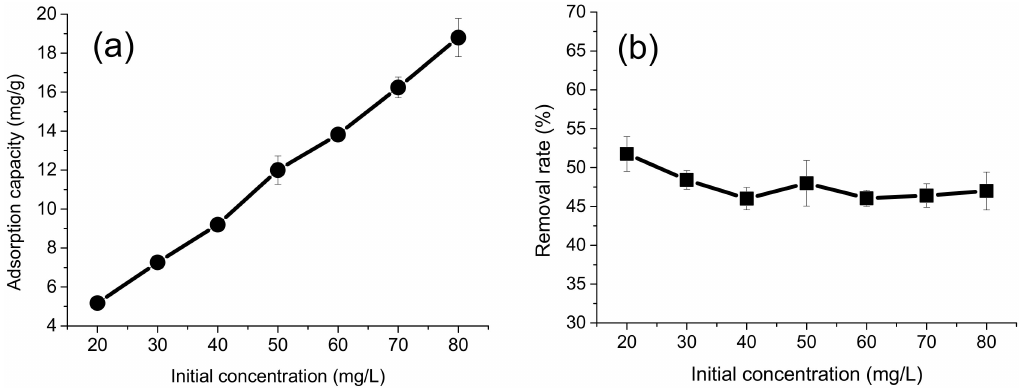
Figure 6. Effect of initial Cr(VI) concentration on the adsorption capacity ( a ) and removal rate ( b ) for